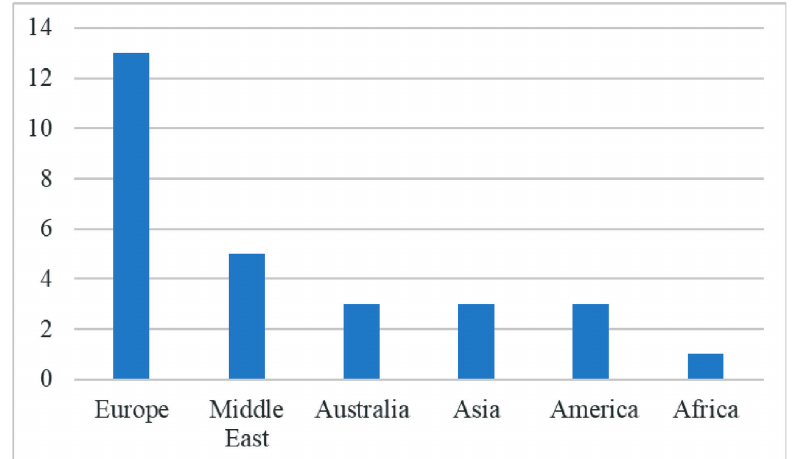
Figure 2. Distribution of papers